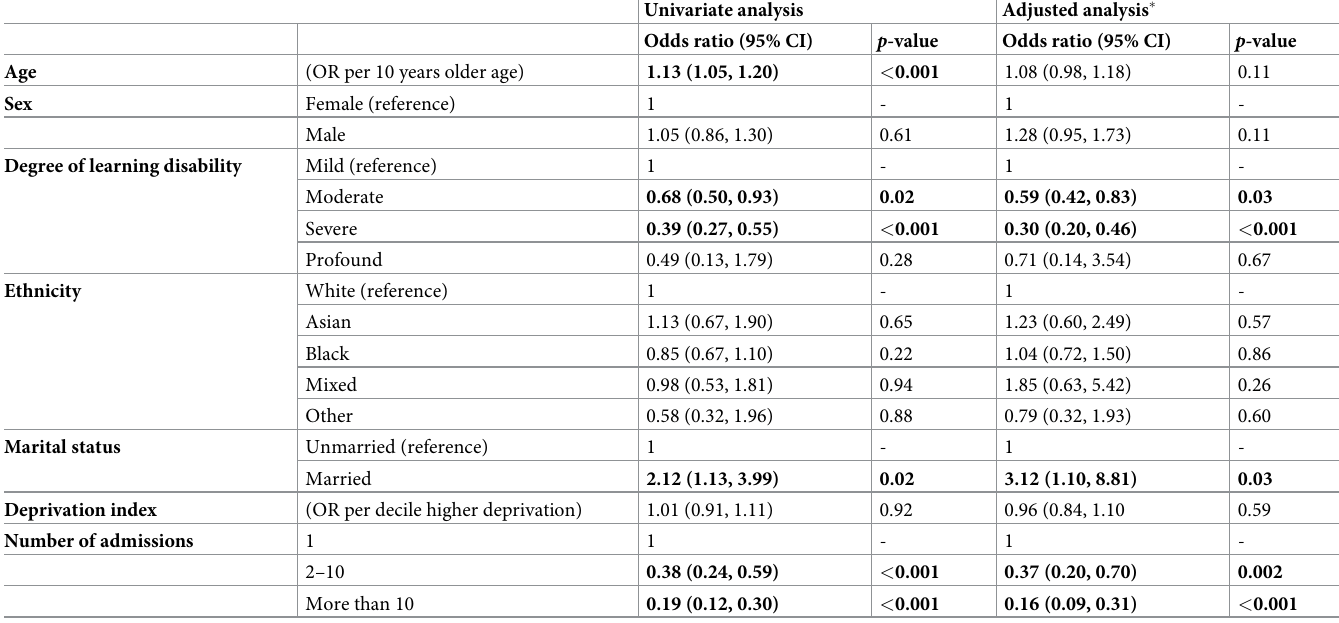
� Adjustment for all variables in the table. Statistically significant results are marked in bold